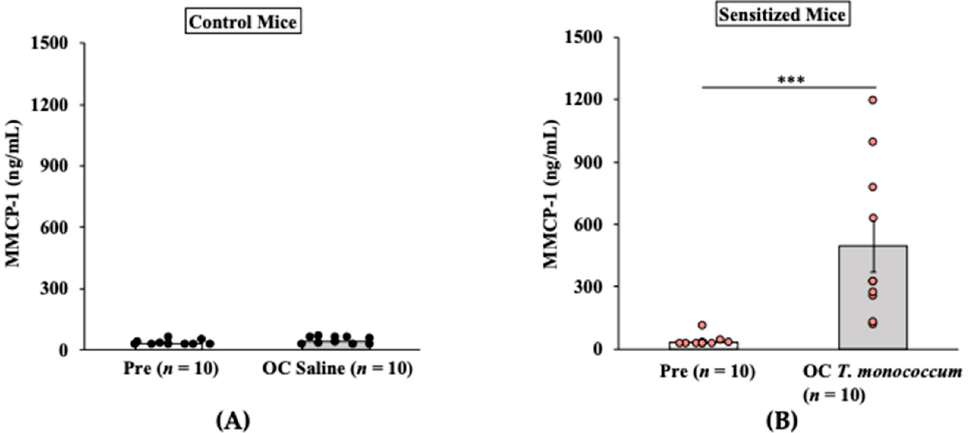
Figure 3. Oral challenge with SSPE from Triticum monococcum (genome AA) elicits a robust mucosal mast cell response (MMCR) in Balb/c mice. Mice were sensitized and orally challenged with T. monococcum SSPE, or saline as described in Materials and Methods. Plasma levels of mucosal mast cell protease (MMCP)-1 levels (ng/mL) in pre- and 1-h post-challenge were measured by ELISA. ( A ) MMCP-1 levels in control mice challenged with saline. ( B ) MMCP-1 levels in allergic mice challenged with T. monococcum SSPE. *** p < 0.005, student’s t -test. n : number of mice, OC: oral